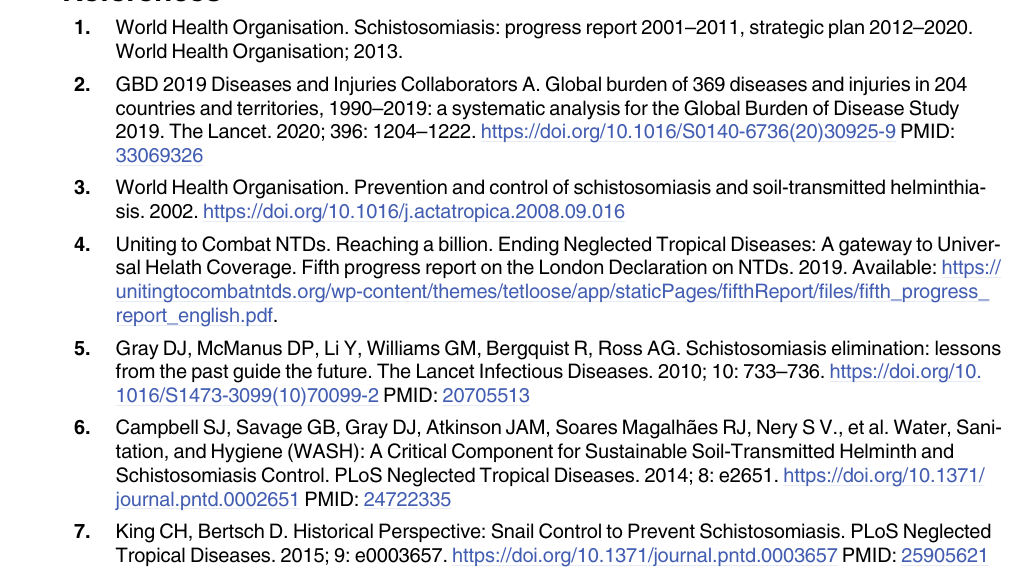
S1 Table. Search results. Classification process and codes, a list of excluded and included studies, experimental setups and extracted